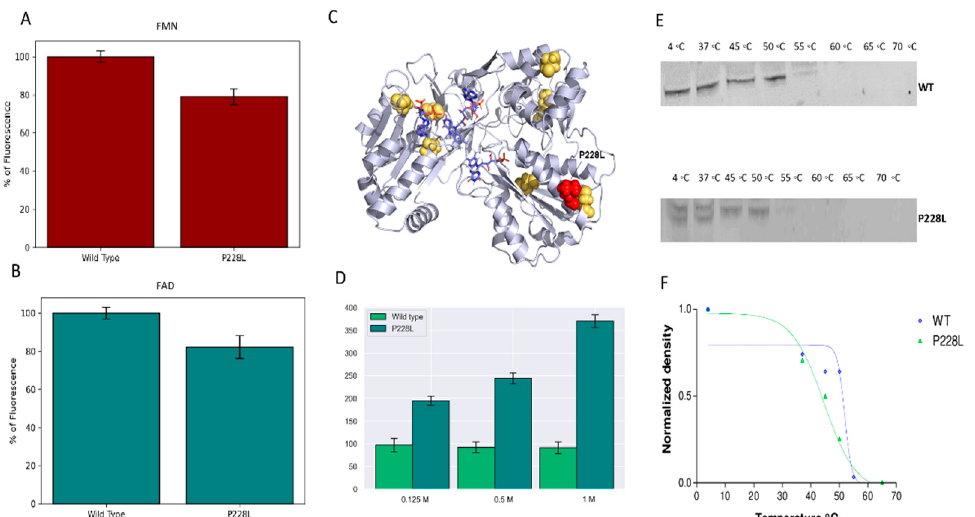
Figure 5. Flavin content and stability of WT and P228L POR. The fluorescence of released FMN/FAD was measured with excitation at 450 nm and emission at 535 nm. ( A ) FMN content and ( B ) FAD content of POR WT and P228L are shown. ( C ) POR structure is illustrated showing the cysteine residues inside or on the surface of the folded protein coloured in yellow. ( D ) Stability analysis of WT and P228L by CPM fluorescence assay. The stability of protein structure was tested by exposure to increasing concentration of urea. The fluorescence emission at 463 nm increased upon unfolding due to increased access of CPM molecules to hidden cysteine residues in the unfolded protein. The P228L mutant of POR was less stable, the P228L unfolded at a lower concentration of urea, and the flavin content was lower than WT POR. ( E ) Analysis of WT and P228L stability by FASTpp assay. FASTpp of WT and P228L were analyzed by Western blot as described in the methods. Original western blot images are provided in supplementary materials as supplementary figures 1 to 4. ( F ) Representative melting curve of WT (Tm 51.7 °C) and P228L (Tm 44.4 °C). The P228L mutant of POR was less stable than the WT POR protein and was degraded faster and at lower temperatures upon thermolysin treatment.